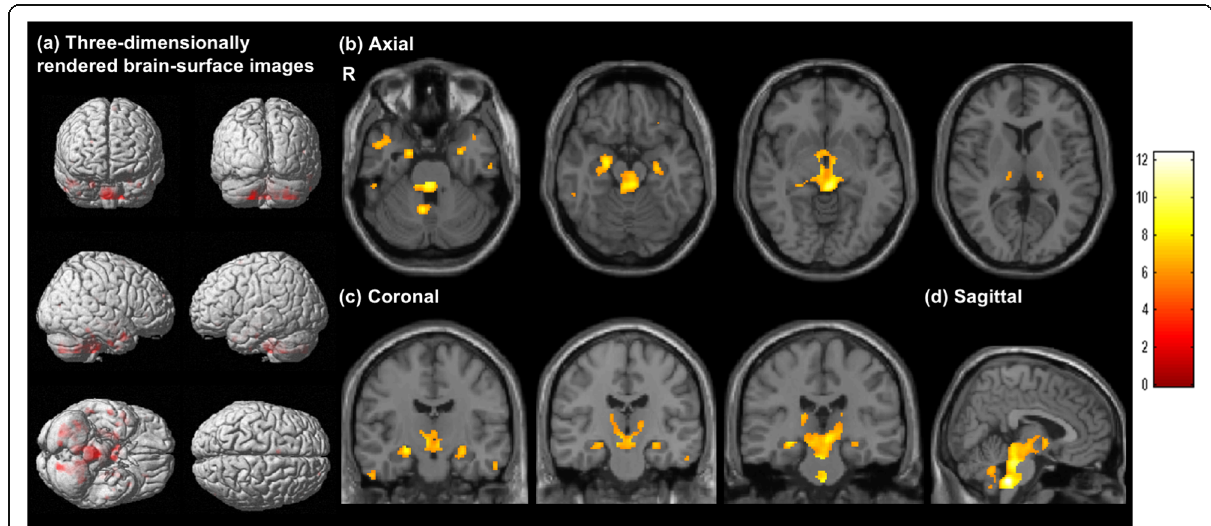
Fig. 2 Voxel-wise analysis of [ 11 C]DPA713 binding potential images ( p < 0.05, family-wise error corrected). Regions with a significant increase of [ 11 C]DPA713 binding potential (BP ND ) are highlighted on three-dimensionally rendered brain-surface images ( a ). Axial ( b ), coronal ( c ), and sagittal ( d ) magnetic resonance images show the regions with a significant increase of [ 11 C]DPA713 BP ND ( p < 0.05, family-wise error corrected). The color bar denotes the T value (0 – 12). R,